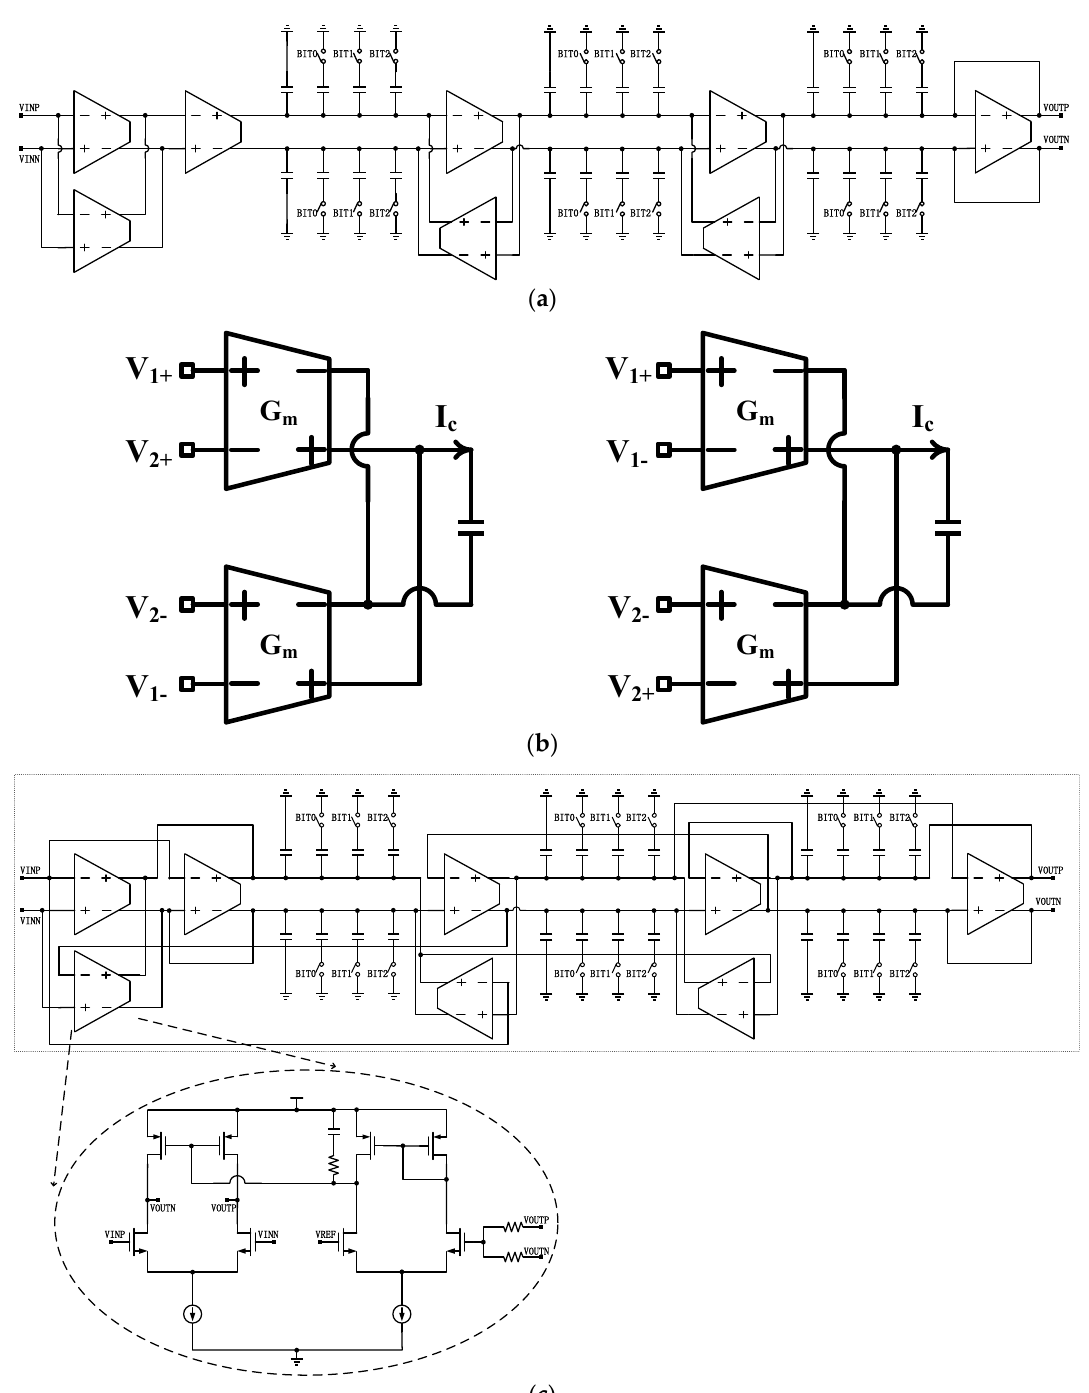
Figure 9. Traditional G m -C low-pass filter (LPF) with its modification: ( a ) traditional G m -C LPF; ( b ) modification method; ( c ) modified G m -C LPF.